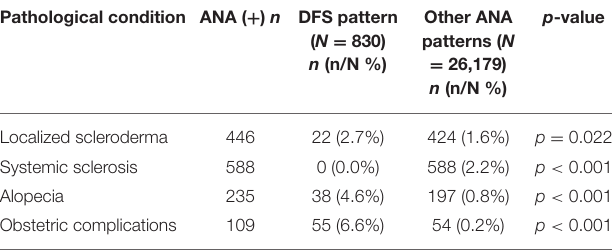
TABLE 4 | Prevalence of common manifestations and AiDs in cases with DFS pattern. Classification Type